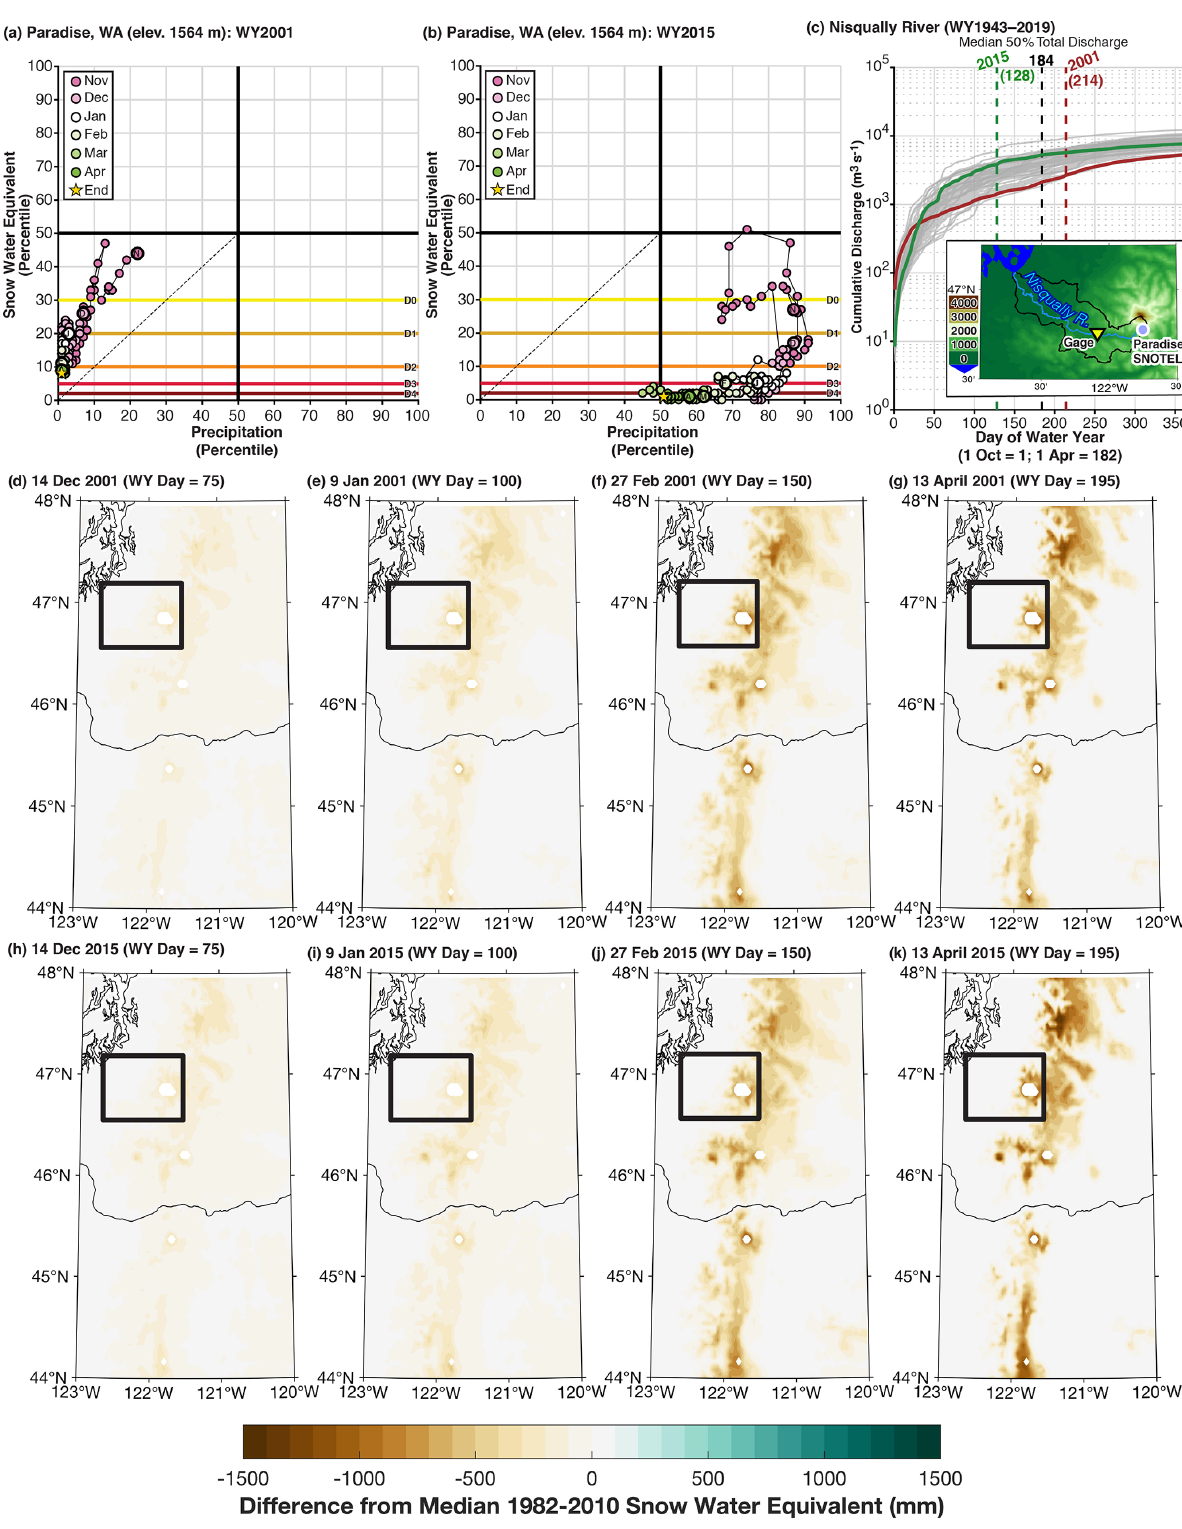
Figure 4. Comparison of dry (a) and warm (b) snow drought conditions in the Pacific Northwest at Paradise, Washington, during water years (WYs) 2001 and 2015, respectively. (c) Cumulative discharge (in m 3 s − 1 ) from the Nisqually River with vertical dashed lines indicating the date at which 50% of the total WY runoff occurred. (d–g) Spatial snow water equivalent anomalies (in millimeters) during WY 2001 from the UAswe product (Zeng et al., 2018). (h–k) As in (d) – (g) but for WY